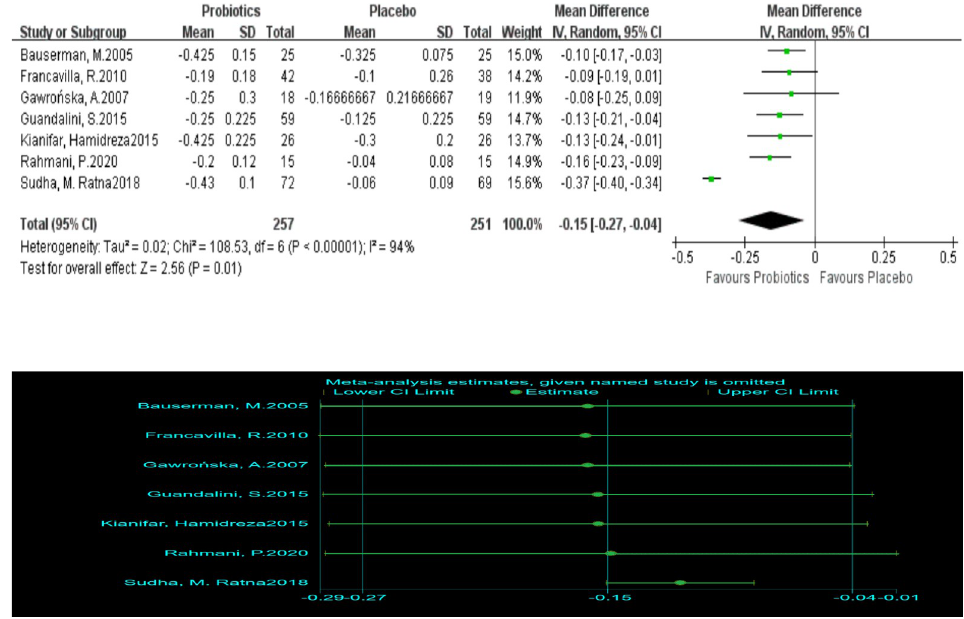
Fig 4. Forest and sensitivity analysis plot comparing SAP between the probiotic and placebo